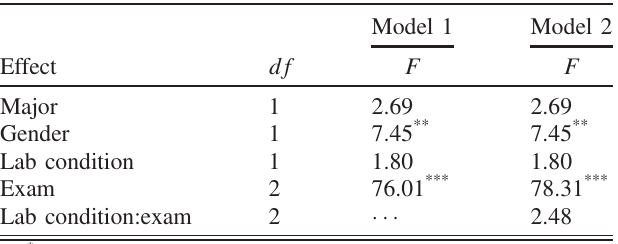
TABLE IV. Type III analysis of variance table for the mixed model regression analyses for exam score (calculated using Satterthwaite ’ s approximation) validate the regression analyses, finding no overall effect for lab conditions and no interaction with